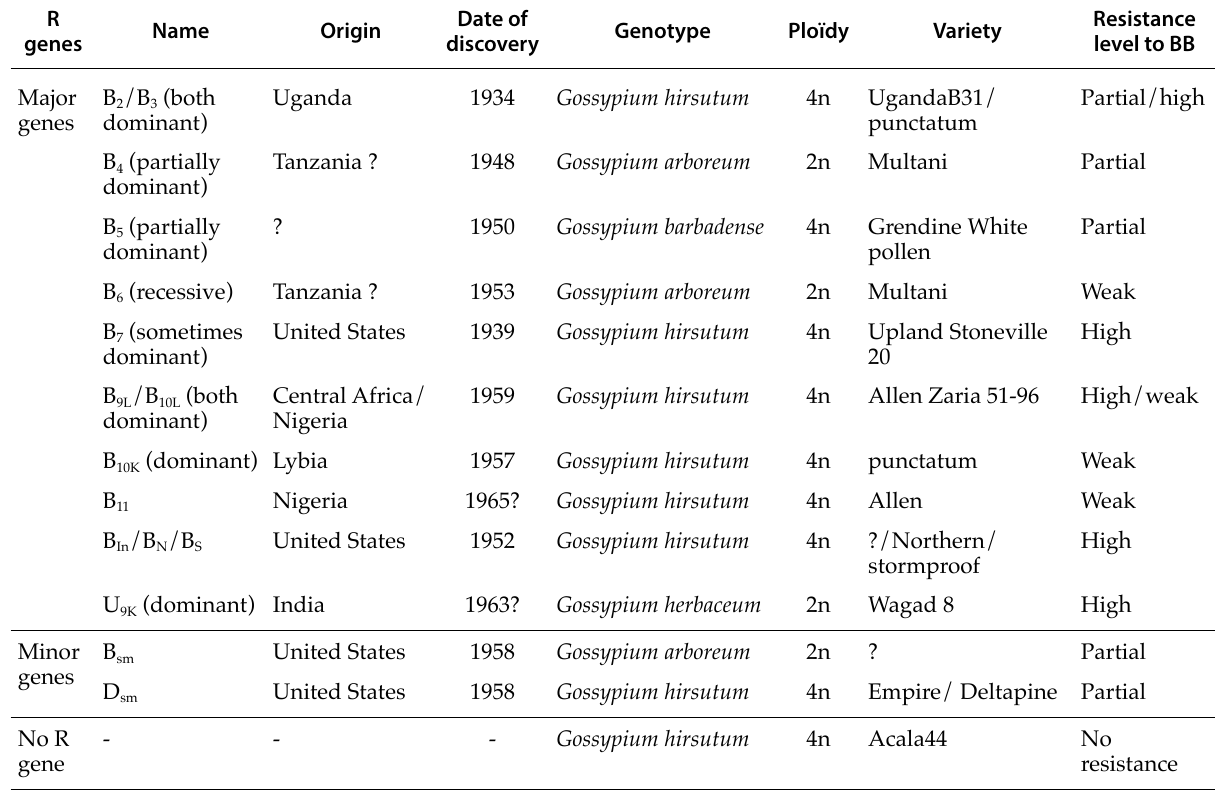
Table 1. The main cotton resistance genes. R